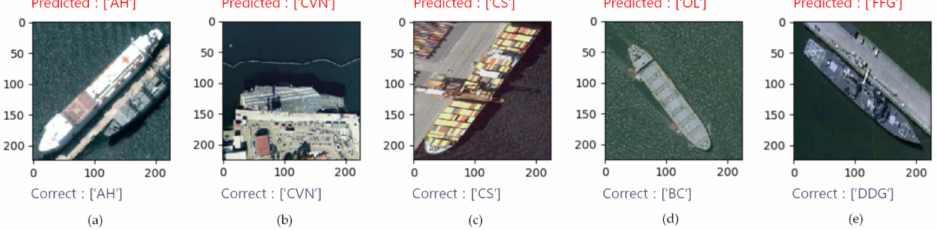
Figure 13. Classification results for AH, CVN, CS, BC and DDG. ( a – c ) are visualizations of the correct classification results; ( d , e ) are visualizations of misclassification